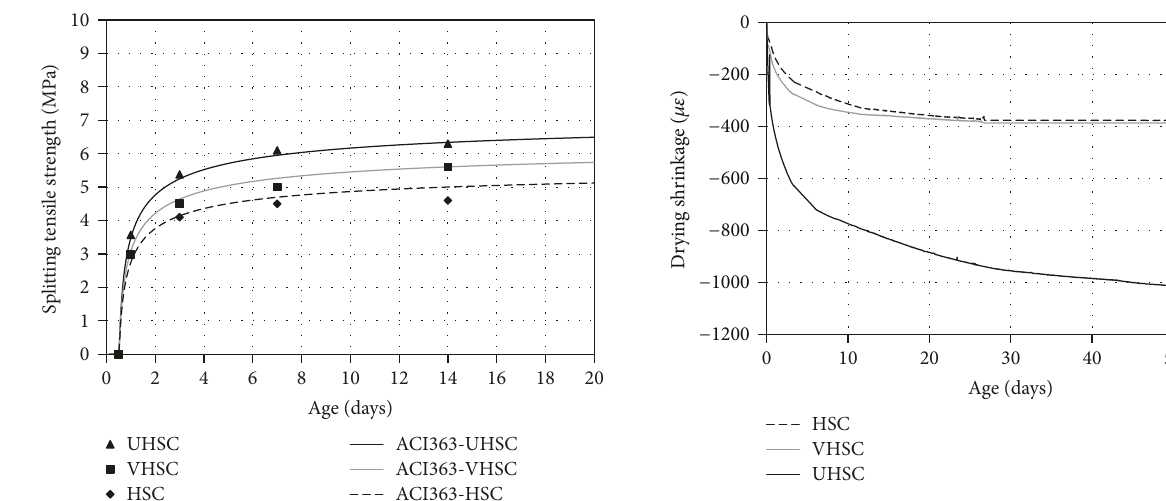
Figure 6: Drying shrinkage of concrete with different strength levels.